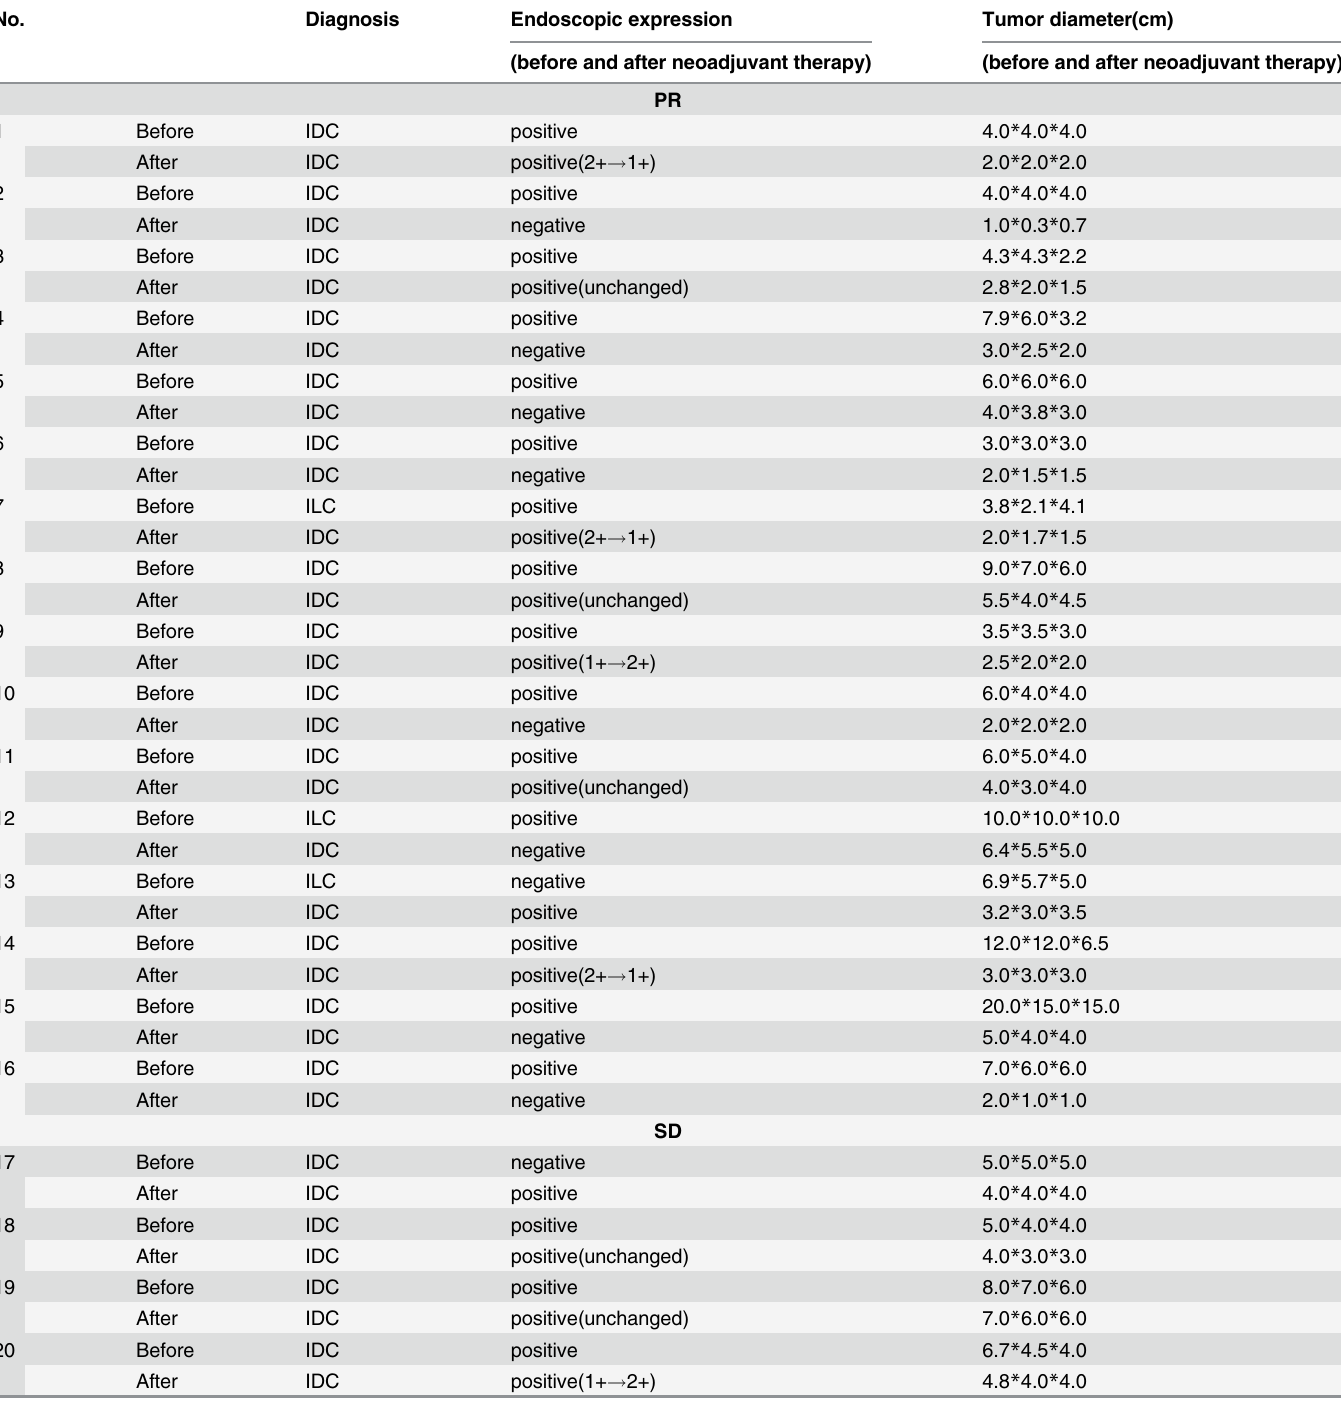
Table 1. Clinical and histological characteristics of TNBC patients before and after neoadjuvant chemotherapy. (n = 20). No. Diagnosis Endoscopic expression Tumor diameter(cm) (before and after neoadjuvant therapy) (before and after neoadjuvant therapy)